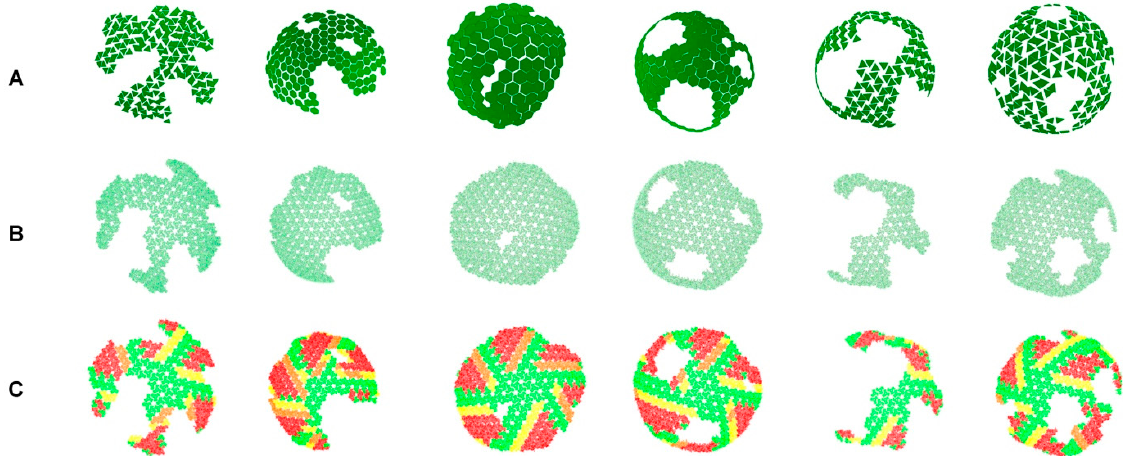
Figure 4. Models of the HIV-1 Shells from Literature (Colored Trimer Model). ( A ) Schematic 3D models based on 2D figures of published MA shell arrangements. Each hexagon representing six MA trimers. Data from ( A ) were inputted into the pipeline shown in Figure 1, and the output is shown in ( B ). Each model and its constituent trimers were assessed for overlap with neighboring trimers and color ‐ coded to their degree of overlap ( C ). Trimers that had zero structural overlap with any adjacent trimer and had a center ‐ of ‐ mass to center ‐ of ‐ mass distance of 5.0 ‐ 5.2 nm were considered plausible locations and were colored green. Trimers with zero overlap with adjacent trimers with a distance of 5.0–4.4 nm were colored yellow. Orange trimers had approximately 5% structural overlap with adjacent trimers (4.4–4.0 nm) and trimers with higher than 5% overlap were colored red.